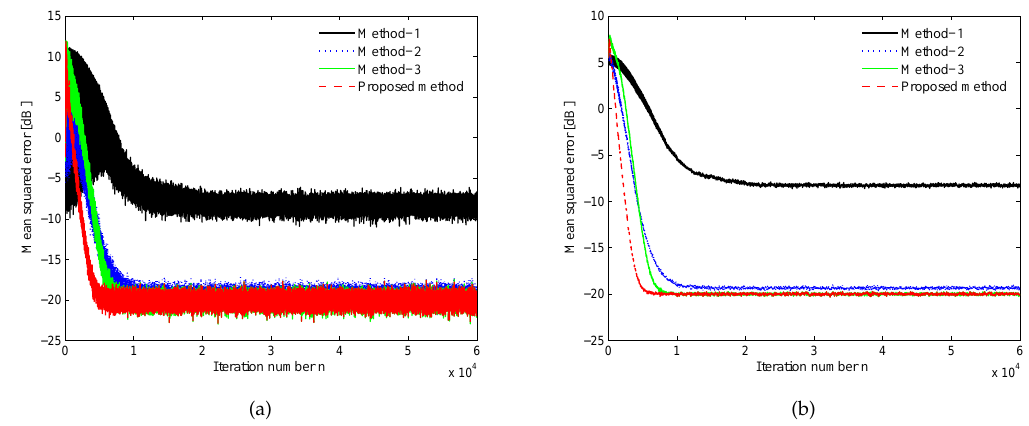
Figure 6. Comparison between the residual errors of Method 1, Method 2, and the proposed method for the fixed acoustic path S ( z ) shown in Figure 4a. ( a ) Mean square error E [ e 2 ( n )] . ( b ) Mean square error E [ e 2 ( n )] obtained by averaging the square values of 50 past residue errors.